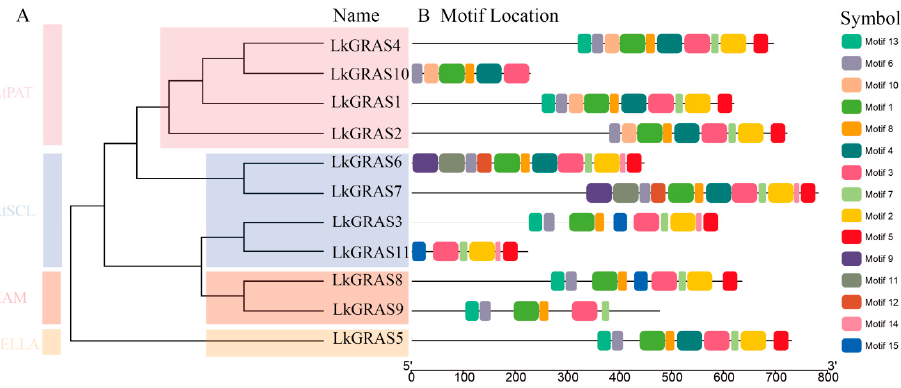
Figure 3. Phylogenetic relationships and conserved motifs of LkGRAS proteins. Phylogenetic tree ( A ) of LkGRAS proteins was constructed by using the neighbor-joining (NJ) method with 1000 boot- strap replicates in MEGA 7.0, and conserved motifs ( B ) were obtained using MEME.